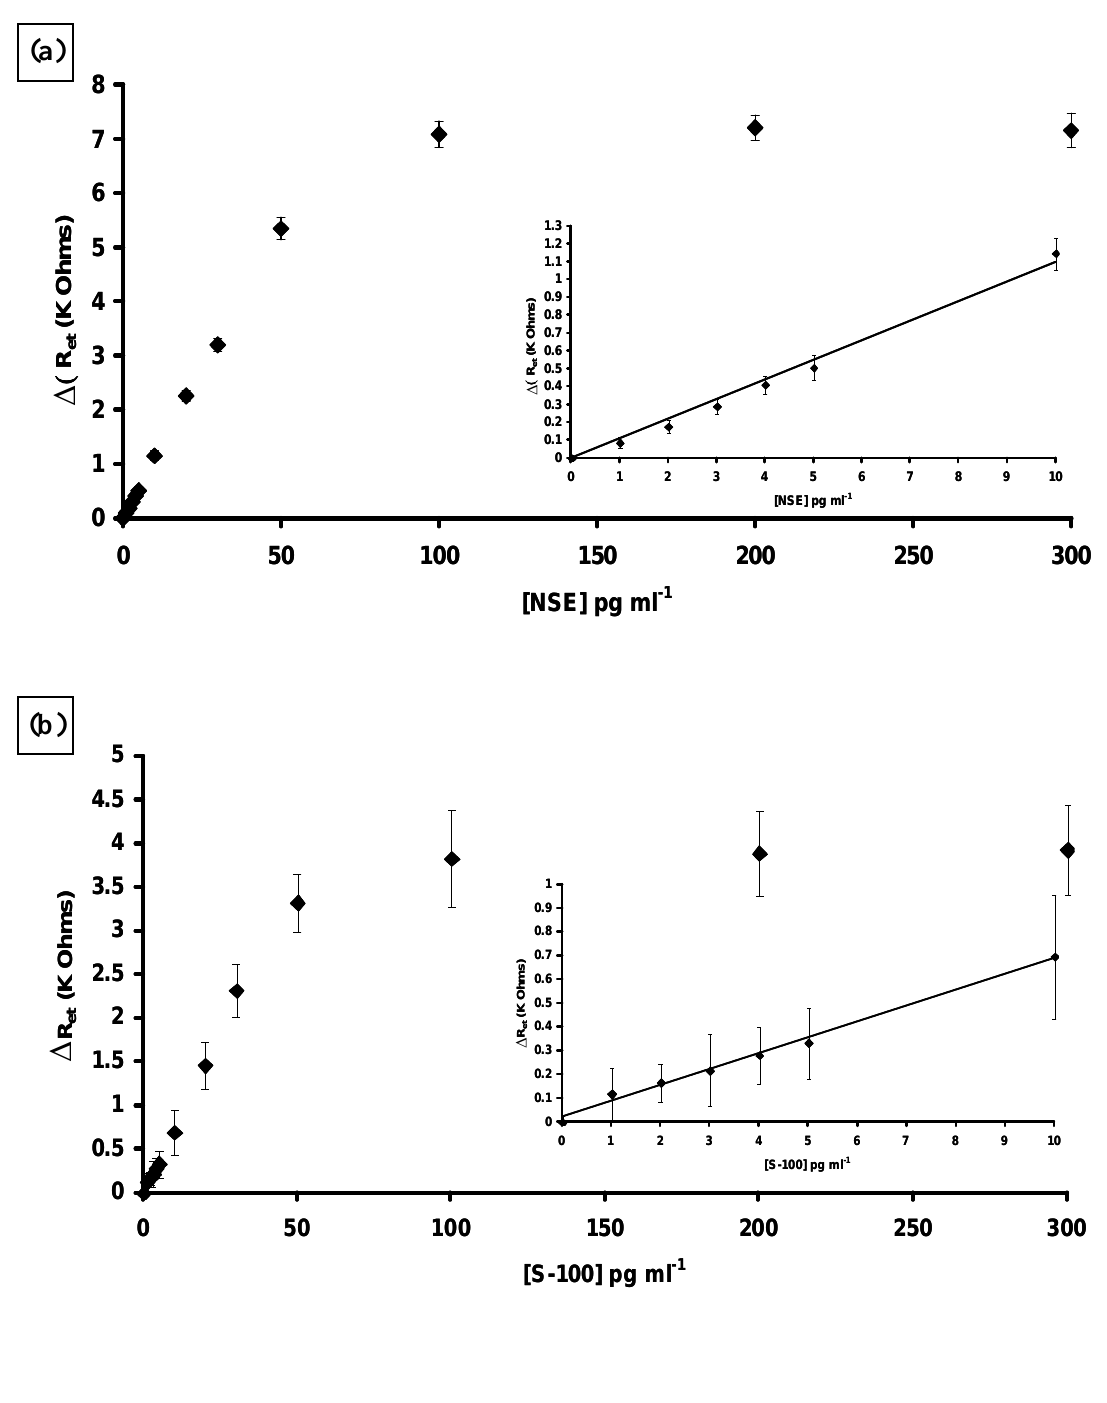
Figure 24. Corrected calibration plots showing changes in electron transfer resistance versus antigen concentration: (a) affinity immobilised ANSE 0–300 pg mL –1 NSE inset 0–10 pg mL –1 NSE (b) affinity immobilised AS100[β] 0–300 pg mL –1 S100[β], inset 0–10 pg mL –1